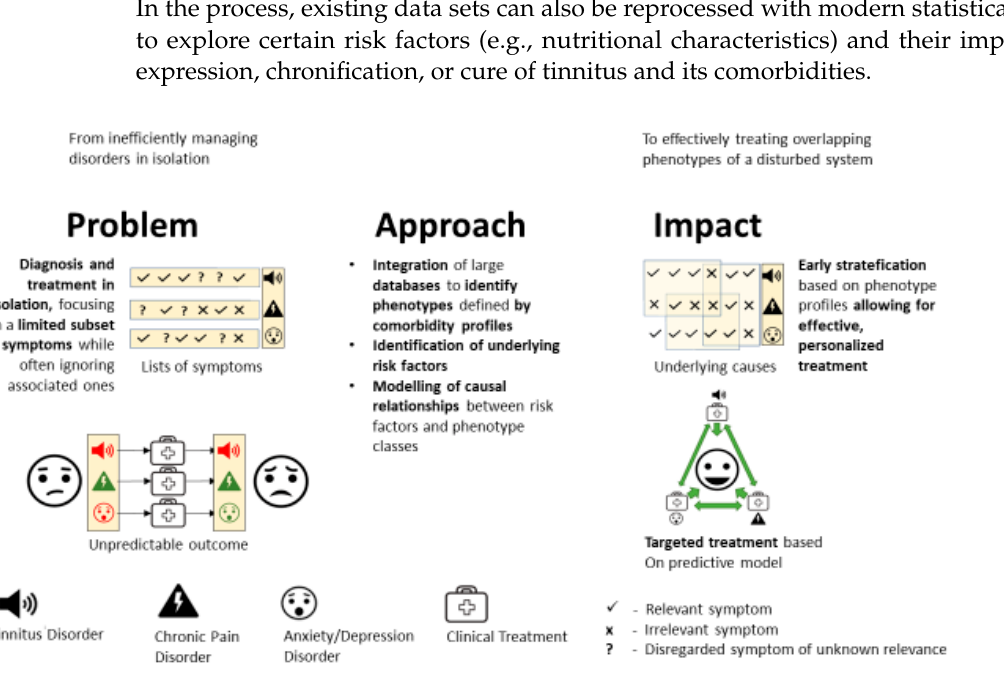
Figure 1. Personalised systems medicine approach.